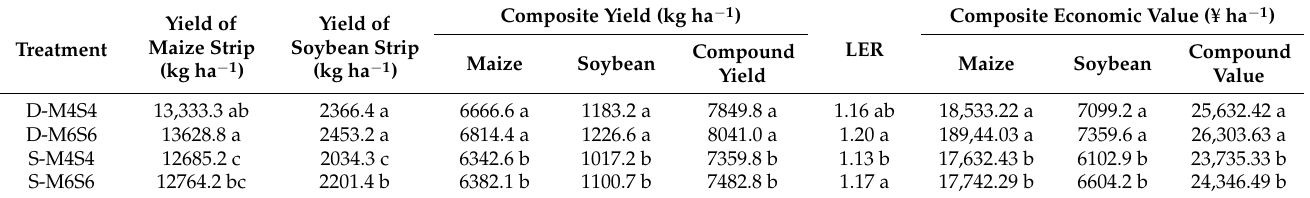
Table 5. Comparison of yield and LER between strip intercropping and single cropping of maize and